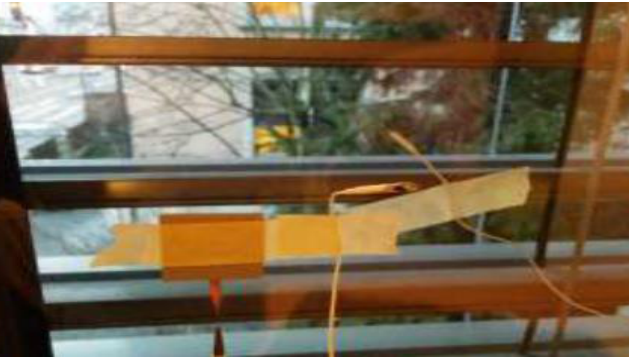
Figure 4. In situ measurement set-up for the glazing U-value determination using HFM method. Reproduced from [44].